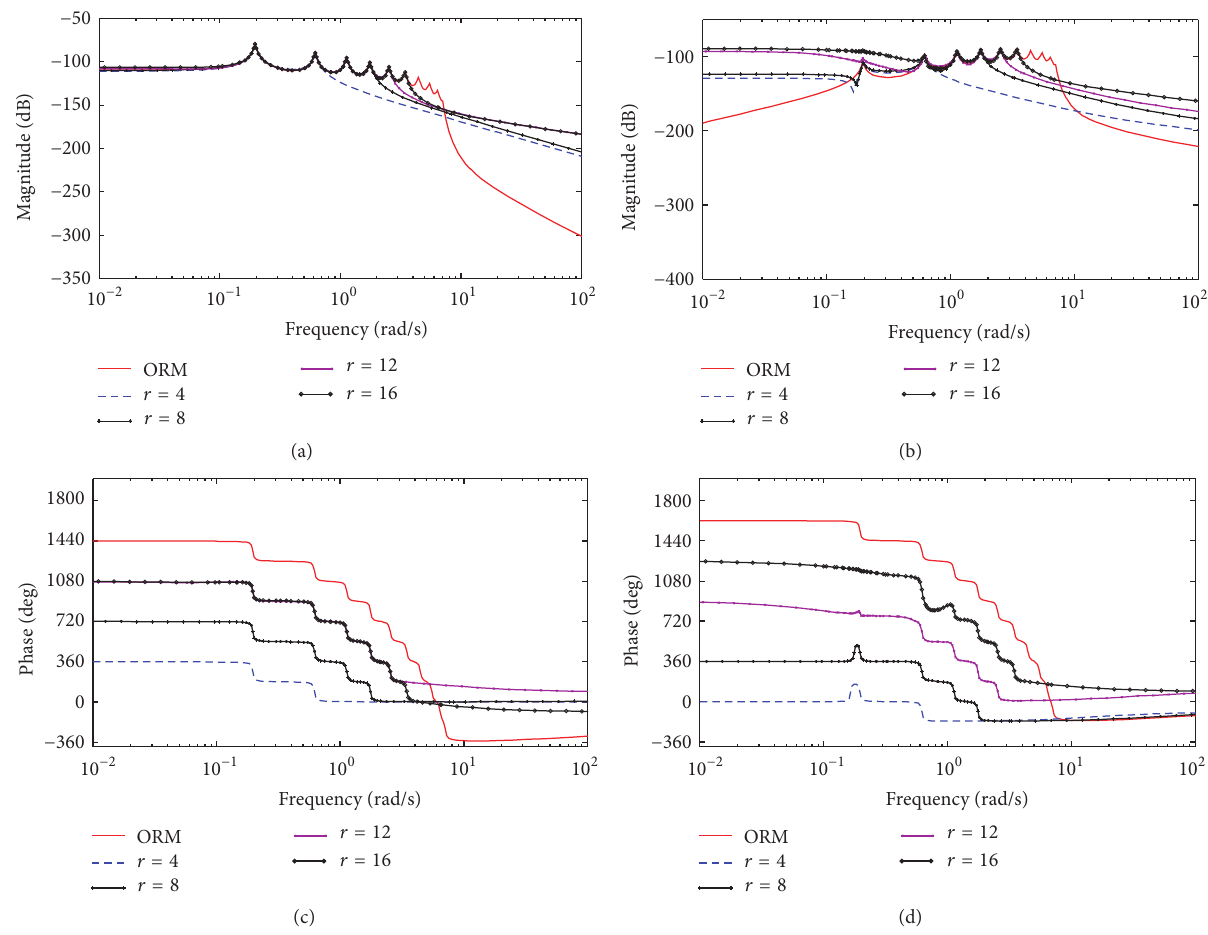
Figure 3: Comparison of transfer functions of the reduced-order model by classical BT method . (a) Magnitude and (c) phase of the displacement transfer functions. (b) Magnitude and (d) phase of the acceleration transfer